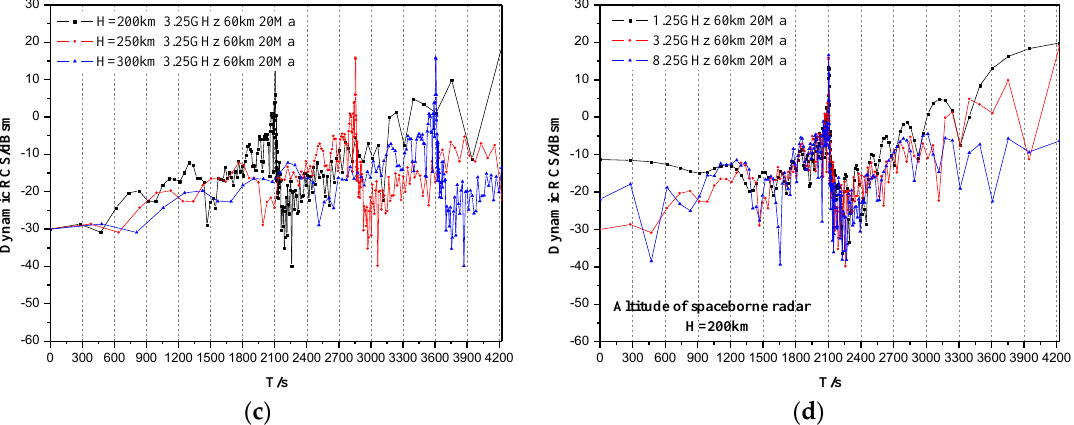
Figure 5. Dynamic RCS sequence comparison of the plasma sheath for hypersonic vehicle flying at different incident electromagnetic frequencies, space-borne radar detection heights, and flying states. ( a ) Space-borne radar at an altitude of 200 km, incident EM wave frequency of 3.25 GHz and the flying speed of the target spacecraft is 20 Mach; flying altitudes of 70, 60, 45 and 30 km are compared. ( b ) Space-borne radar at an altitude of 200 km, incident electromagnetic wave frequency of 3.25 GHz and the target spacecraft flying at an altitude of 60 km; flying speeds of 15, 20 and 25 Mach are compared. ( c ) Incident EM wave frequency of 3.25 GHz, velocity and height are 20 Mach and 60 km above ground, respectively; altitudes of 200, 250 and 300 km are compared. ( d ) Space-borne radar at an altitude of 200 km, velocity and height are 20 Mach and 60 km above ground, respectively; frequencies of 1.25, 3.25 and 8.25 GHz are compared.